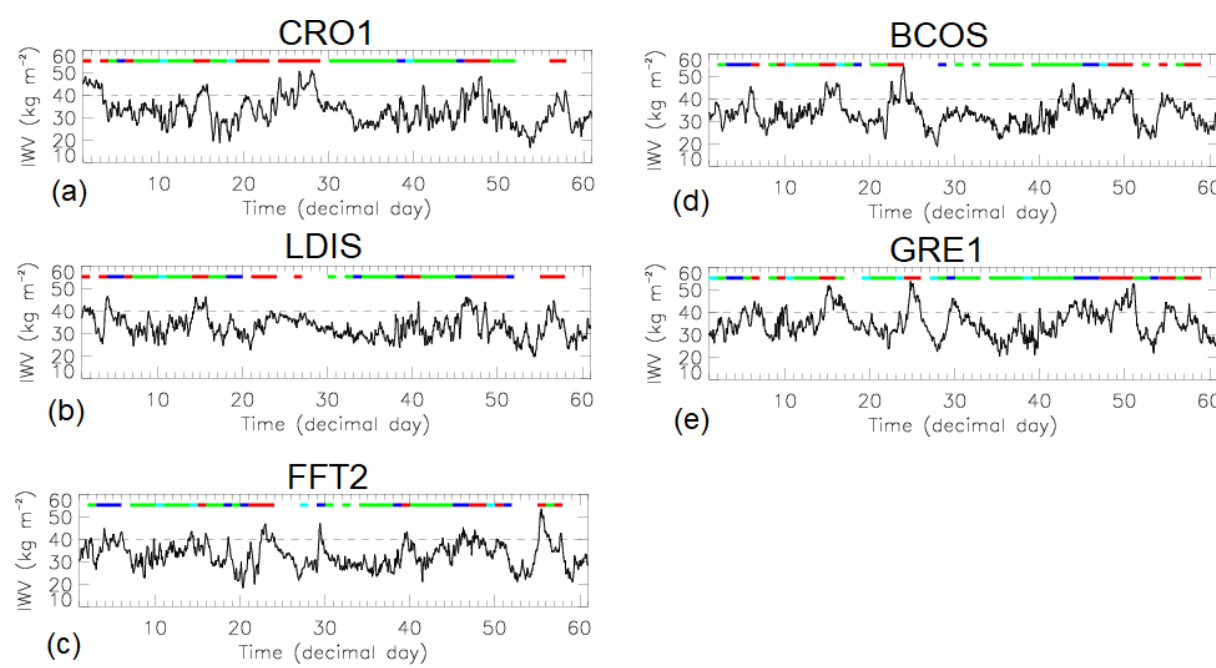
Figure 9. Time series of IWV from five GNSS stations for the period from 1 January to 29 February 2020 as well as the type of cloud patterns in the vicinity of the GNSS sites (see colour code in Fig.